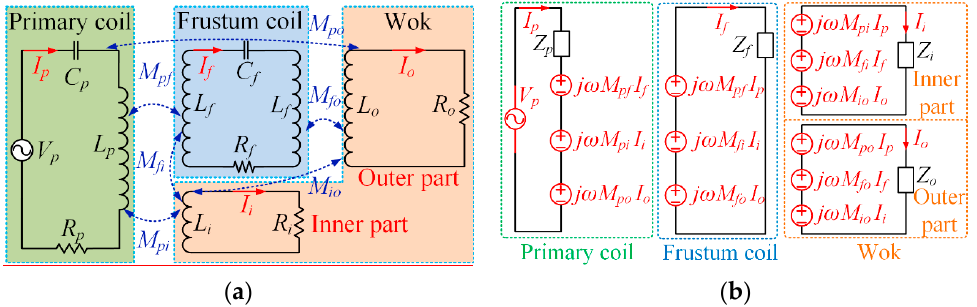
Figure 3. Equivalent circuit represented by ( a ) mutual inductance; ( b ) decoupled circuit.